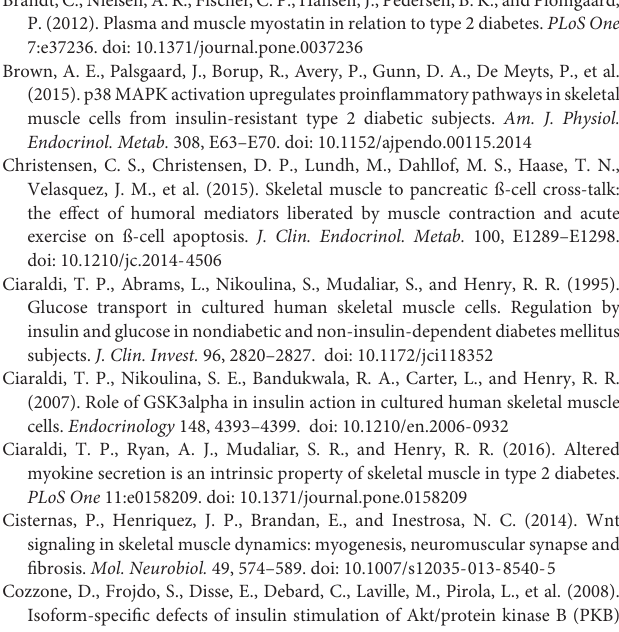
FIGURE S1 | Effects of culture media on INS-1 cell viability and function. INS-1 cells treated with the indicated media, RPMI1640 or RPMI + the indicated proportion of α MEM, for 24 h before harvest or assay. (A) Total cell protein ( n = 12). (B) LDH release ( n = 9). (C) Representative western blot for total and cleaved caspase 3: 1 – RPMI1640, 2 – α MEM, 3–5 – T2D-MT-CM, 6–8 – ND-MT-CM. (D) Total, secreted and cell-associated, insulin content ( n = 12). (E) GSIS ( n = 10). (F) IS max ( n = 5). For panels (D–F) , α MEM = 3:1 RPMI + α MEM. * p < 0.05 vs. paired control. FIGURE S2 | Effects of II and MI conditions on MT viability. MT treated for 48 h (cell harvesting). (A) Total cell protein ( n = 12–14). (B) Representative western blot for total and cleaved caspase 3: cont – Jurkat cell extract treated + cytochrome C, α MEM = 3:1 RPMI + α MEM not conditioned, + II = 3:1 RPMI + ( α MEM not conditioned + LPS), + MI = 3:1 RPMI + ( α MEM not conditioned + MI mix). FIGURE S3 | Effects of II and MI media on INS-1 cell viability and function. INS-1 cells treated with the indicated media for 24 h before harvest or assay. (A) Total cell protein ( n = 10–12). (B) LDH release ( n = 10–12). (C) Representative western blots for total and cleaved caspase 3: I – non-conditioned α MEM, 1 – control, 2